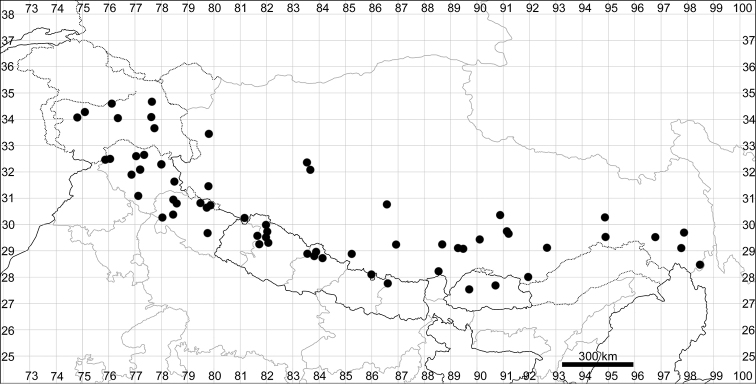
Distribution map of Dysphanianepalensis.